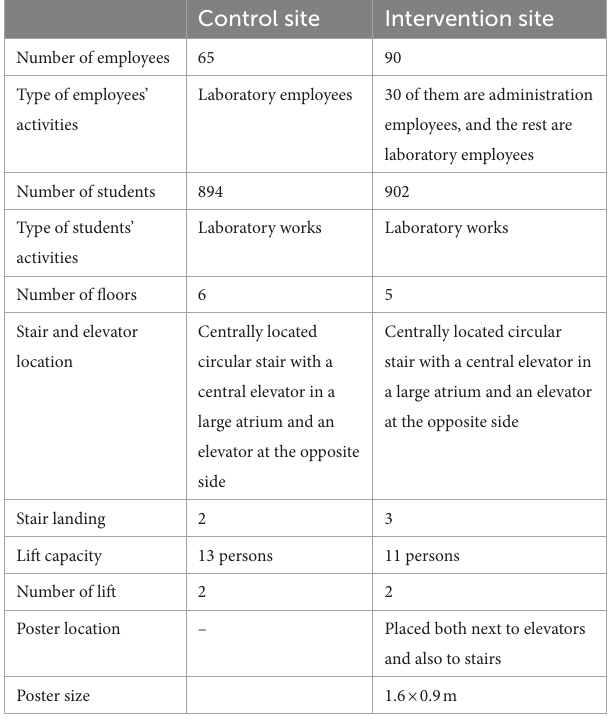
TABLE 1 Characteristics of the buildings and